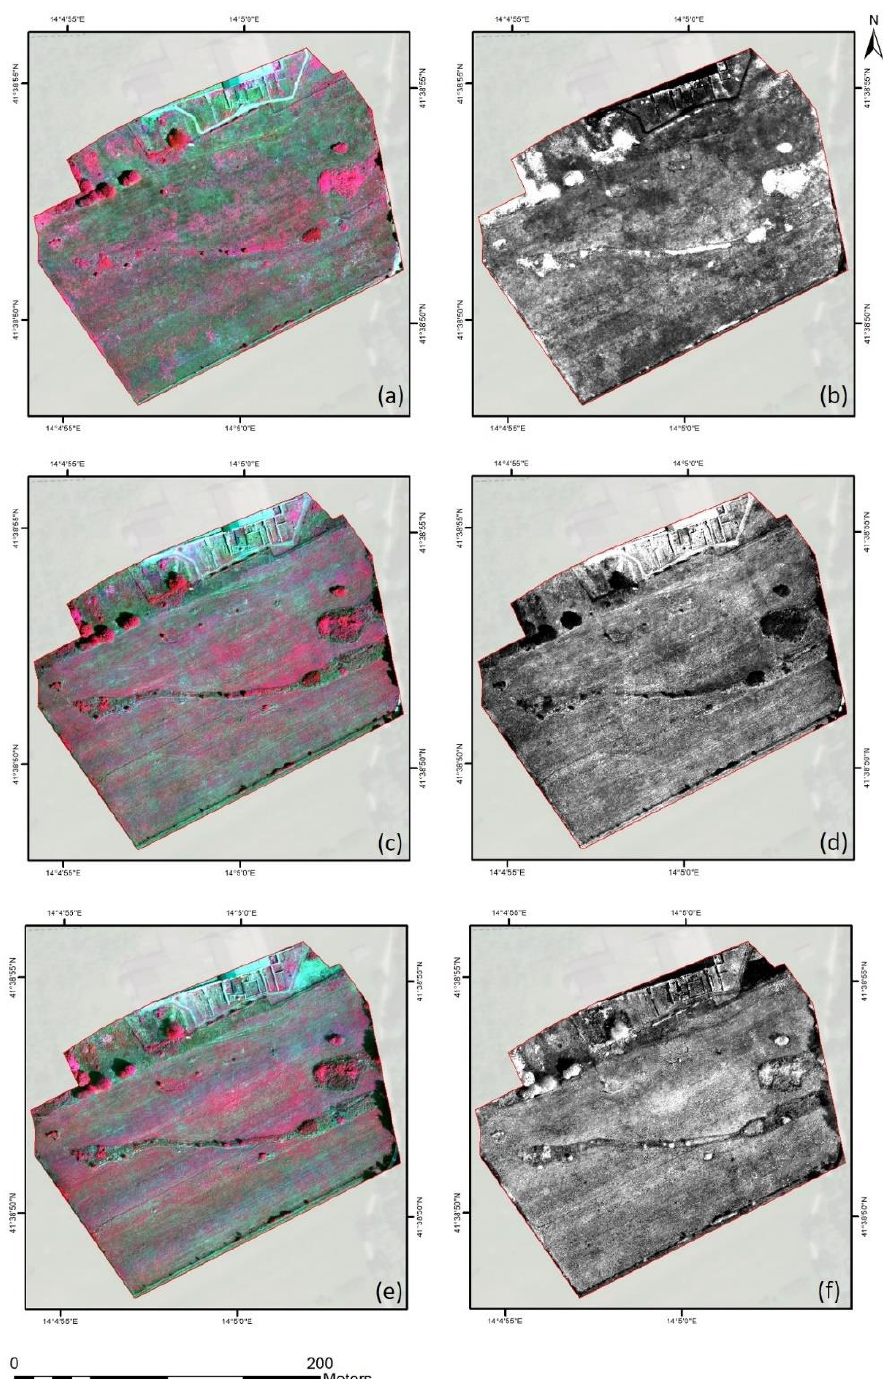
Figure 13. ( a ) July FCIR; ( b ) July NLI with M = 6.4; ( c ) August FCIR; ( d ) August OSAVI with M = 2.6; ( e ) September FCIR; ( f ) September GNDVI with M = 3.1. All views were obtained using radiometric enhance standard deviation (±2 σ) method.